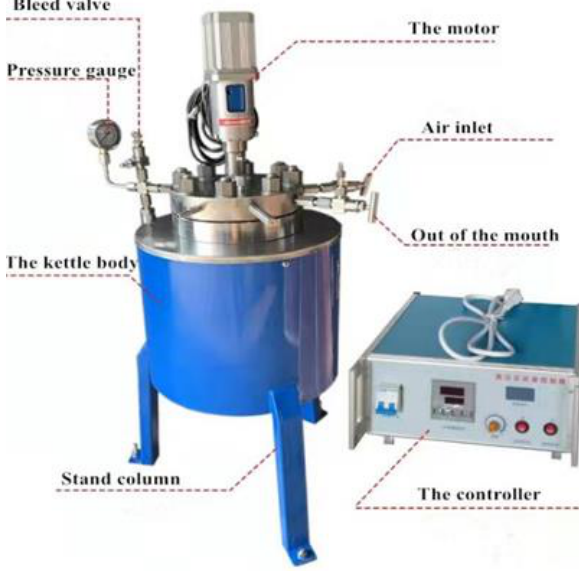
Figure 1. Titanium high-pressure reactor.